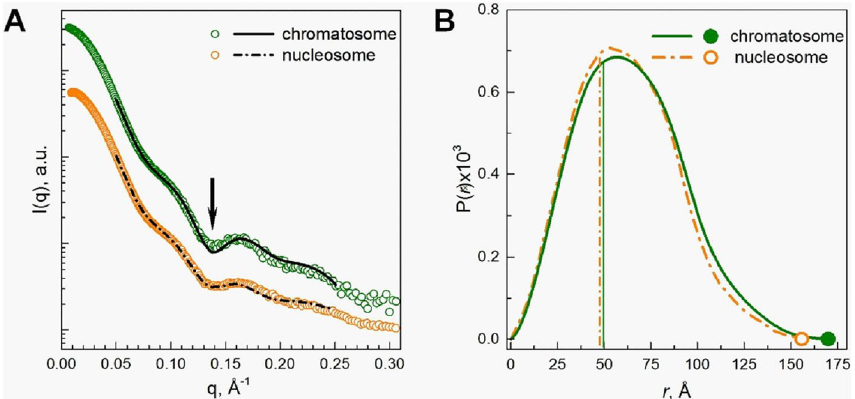
Figure 5. ( A ) Solution SAXS spectra, and ( B ) distance distribution functions P(r) calculated from the SAXS spectra of the 177 bp nucleosome (orange curve and points) and chromatosome (green curve and points). In ( A ), points are for the experimental data; black curves show the SAXS form factors calculated from molecular structures modelling the 177 bp nucleosome and chromatosome. For the chromatosome, the model was built using the crystal structure of the 197 bp chromatosome with linker DNA length adjusted (shown in Fig. 1); for the 177 bp nucleosome, the model was created using a snapshot of an MD simulation of the 147 bp NCP −1 . In ( B ), vertical lines and stretches of straight linker DNA added. The arrow indicates the dip at q = 0.14 indicate values of R g ; points are for D max (maximal pair distance) determined for the nucleosome (orange) and Å chromatosome (green). See text for details and Fig. S3 and Table S4 of the Supporting Material for more fitting data. OriginPro software 100 (www.origi nlab.com) was used to create the graph from the data generated by the ATSAS 2.8.4 package 91 (www.embl-hambu rg.de/biosa xs/softw